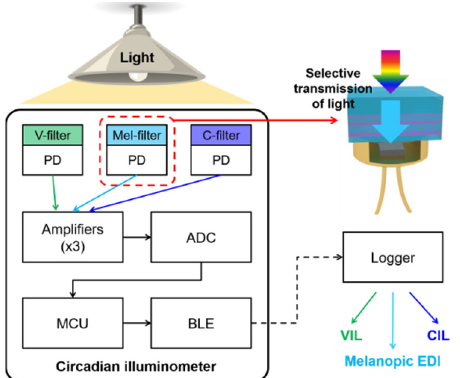
Figure 1. Schematic diagram of the circadian light meter to simultaneously measure the visual illuminance (VIL), melanopic equivalent daylight illuminance (EDI), and circadian illuminance (CIL). PD, photodiode; ADC, analog-to-digital converter; MCU, microcontroller unit; BLE, Bluetooth low